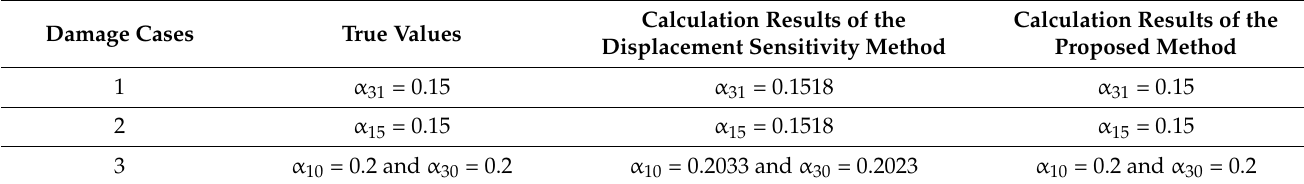
Table 3. The comparison of the calculation results obtained by both the displacement sensitivity method and the proposed